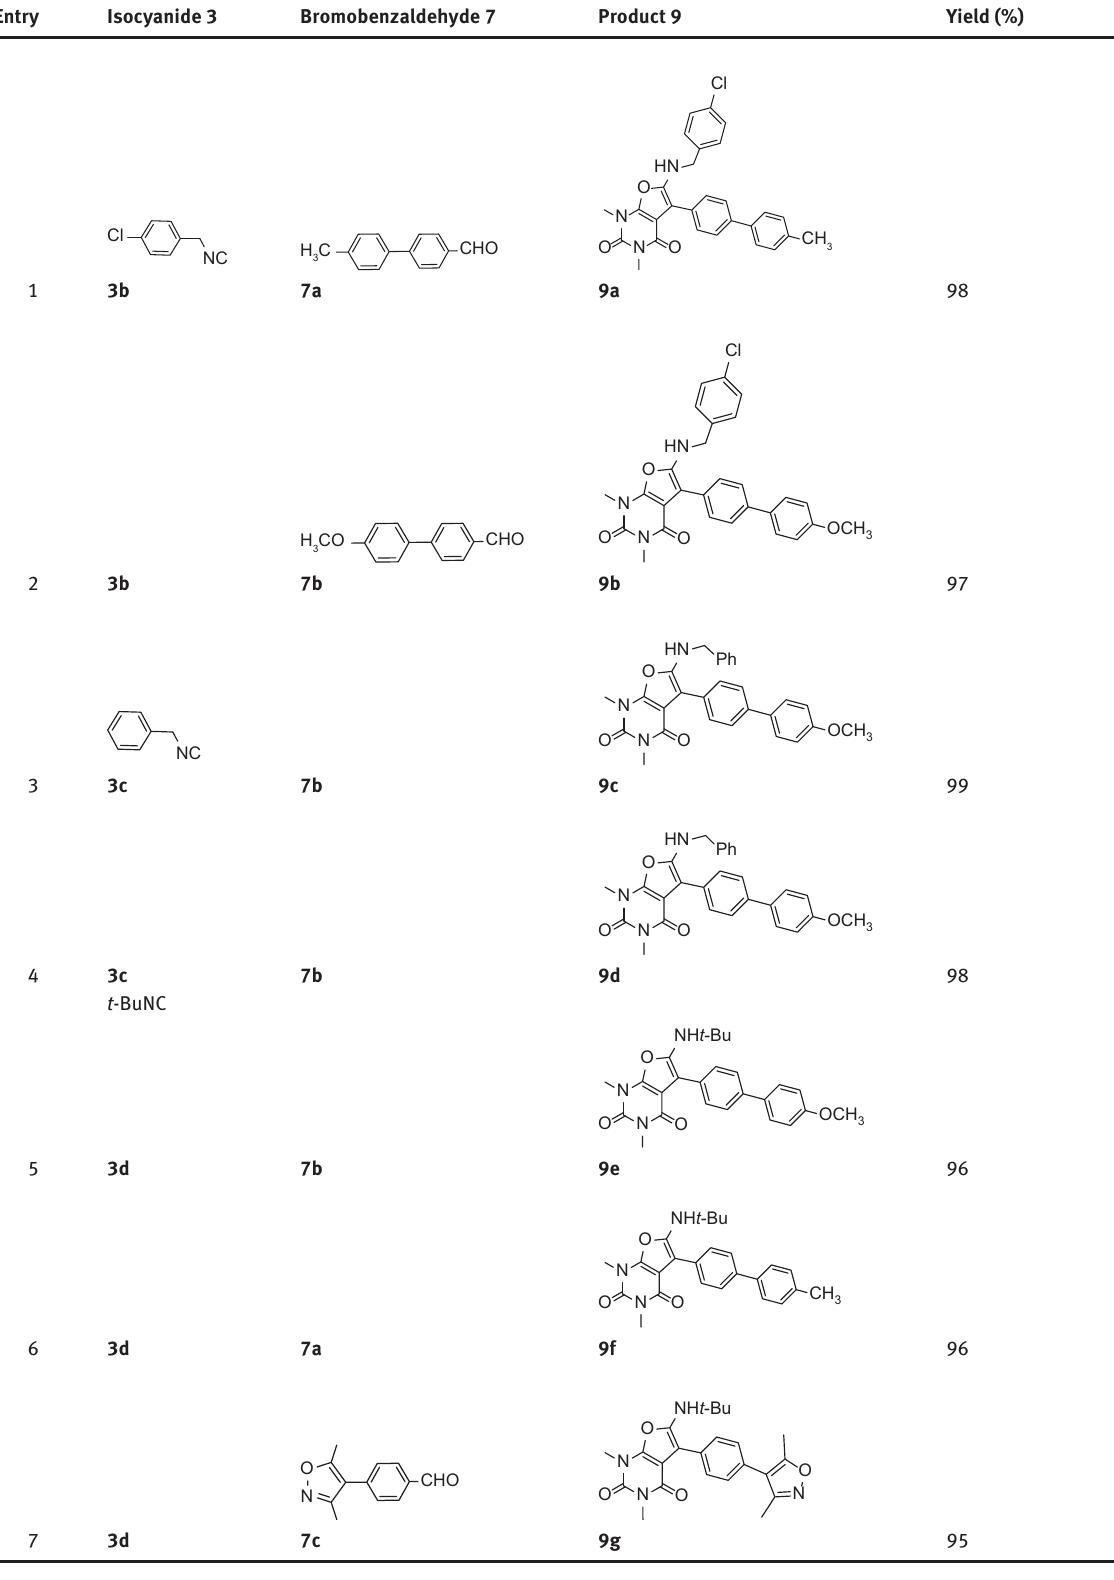
Table 3 Synthesis of furopyrimidine derivatives